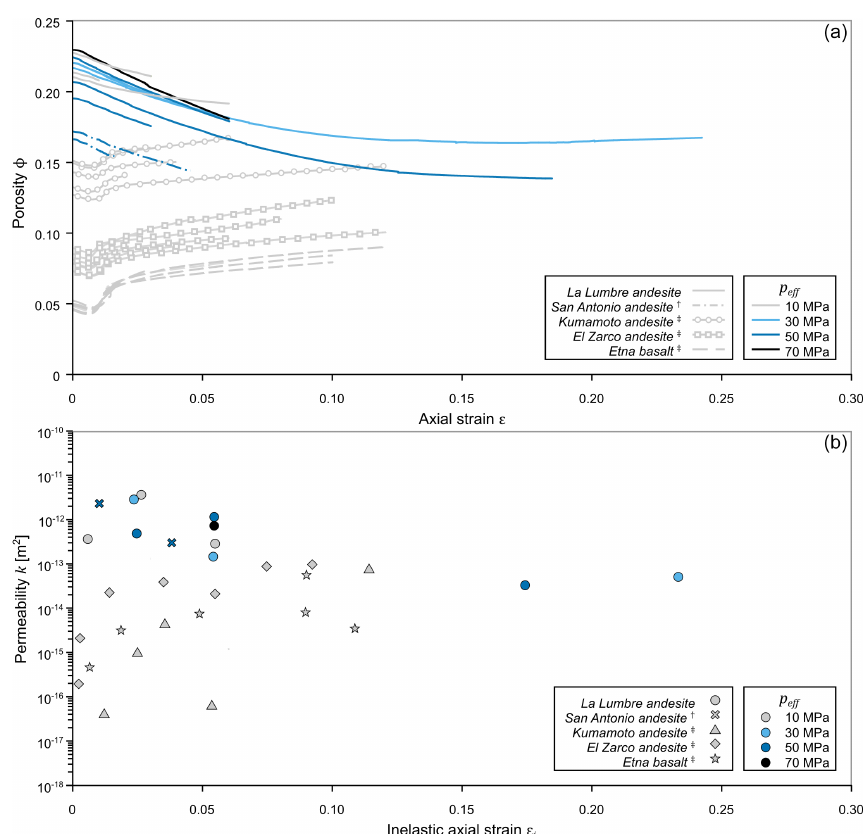
Figure 7. Compiled porosity and permeability data for triaxially deformed volcanic rocks. † Heap et al. (2015a); ‡ Farquharson et al. (2016b). (a) Porosity during deformation, calculated by summing the porosity change (cid:49)φ and the initial sample porosity φ . Samples are distinguished by line and effective pressure by colour. (b) Permeability measured the post-deformation as a function of inelastic strain. Samples are distinguished by symbol and effective pressure by